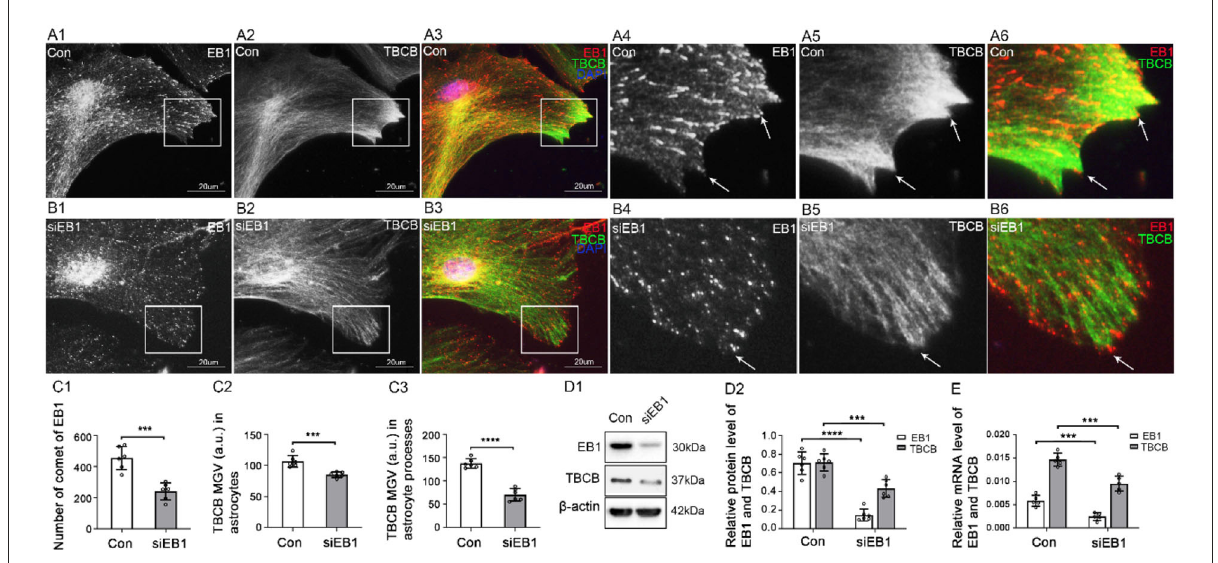
FIGURE4 The expression of TBCB after EB1 was silenced in astrocytes. (A,B) Immunofluorescence showed that EB1 [ (A,B) red signal] was co-expressed with TBCB [ (A,B) green signal] in astrocytes in the negative control group [Con (A) ] and EB1 silence group (B) . (C) The number of EB1 comets and mean gray value (MGV) of TBCB in astrocytes and its processes (MGV = Integrated Density/Area) after EB1 was silenced. (D) Western blot and (E) RT-PCR analysis of the protein and mRNA levels of EB1 and TBCB after EB1 was silenced compared with the control group ( n = 6, p < 0.05). (A–E) Number of panels. *** p < 0.001, **** p <